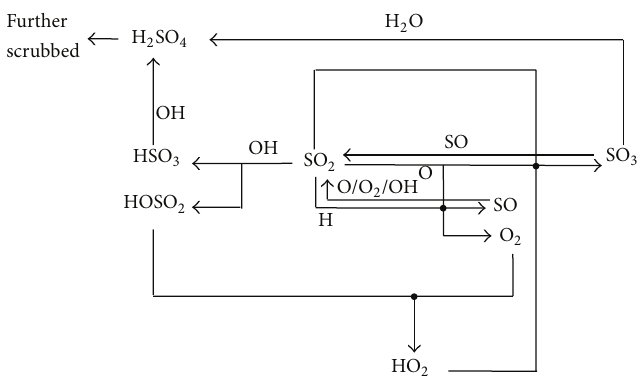
Figure 4: Diagram of main reaction paths and species produced during